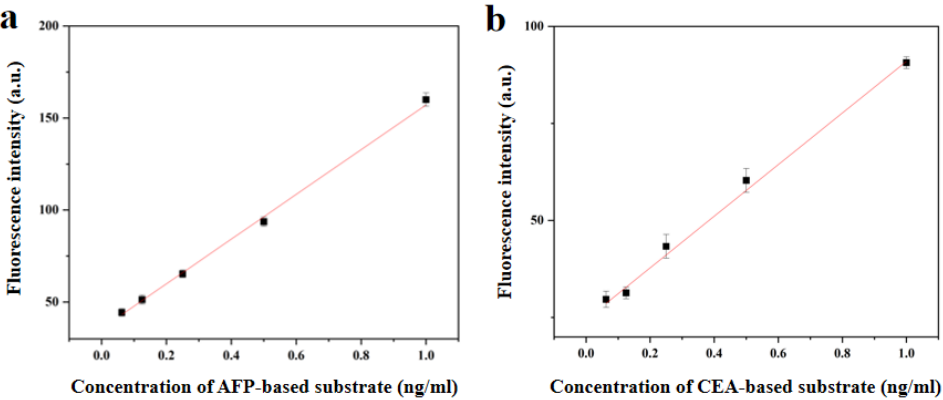
Figure 5. Fluorescence intensity function of ( a ) AFP mixed with a small amount of CEA and other interfering substances ( b ) CEA mixed with a small amount of AFP and other interfering substances drops with different concentrations on photonic crystals. The error line represents the standard deviation of the three repeated measurements.